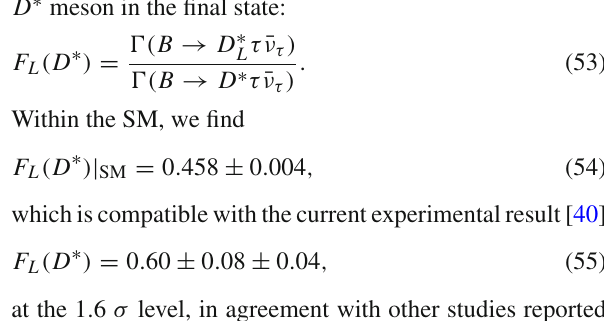
Fig. 8 Summary of the potential enhancements of B ( B − → e − ¯ ν e ) corresponding to the two allowed regions for the C u ,(cid:2) , along with the SM value and experimental solutions for C u ,(cid:2) T